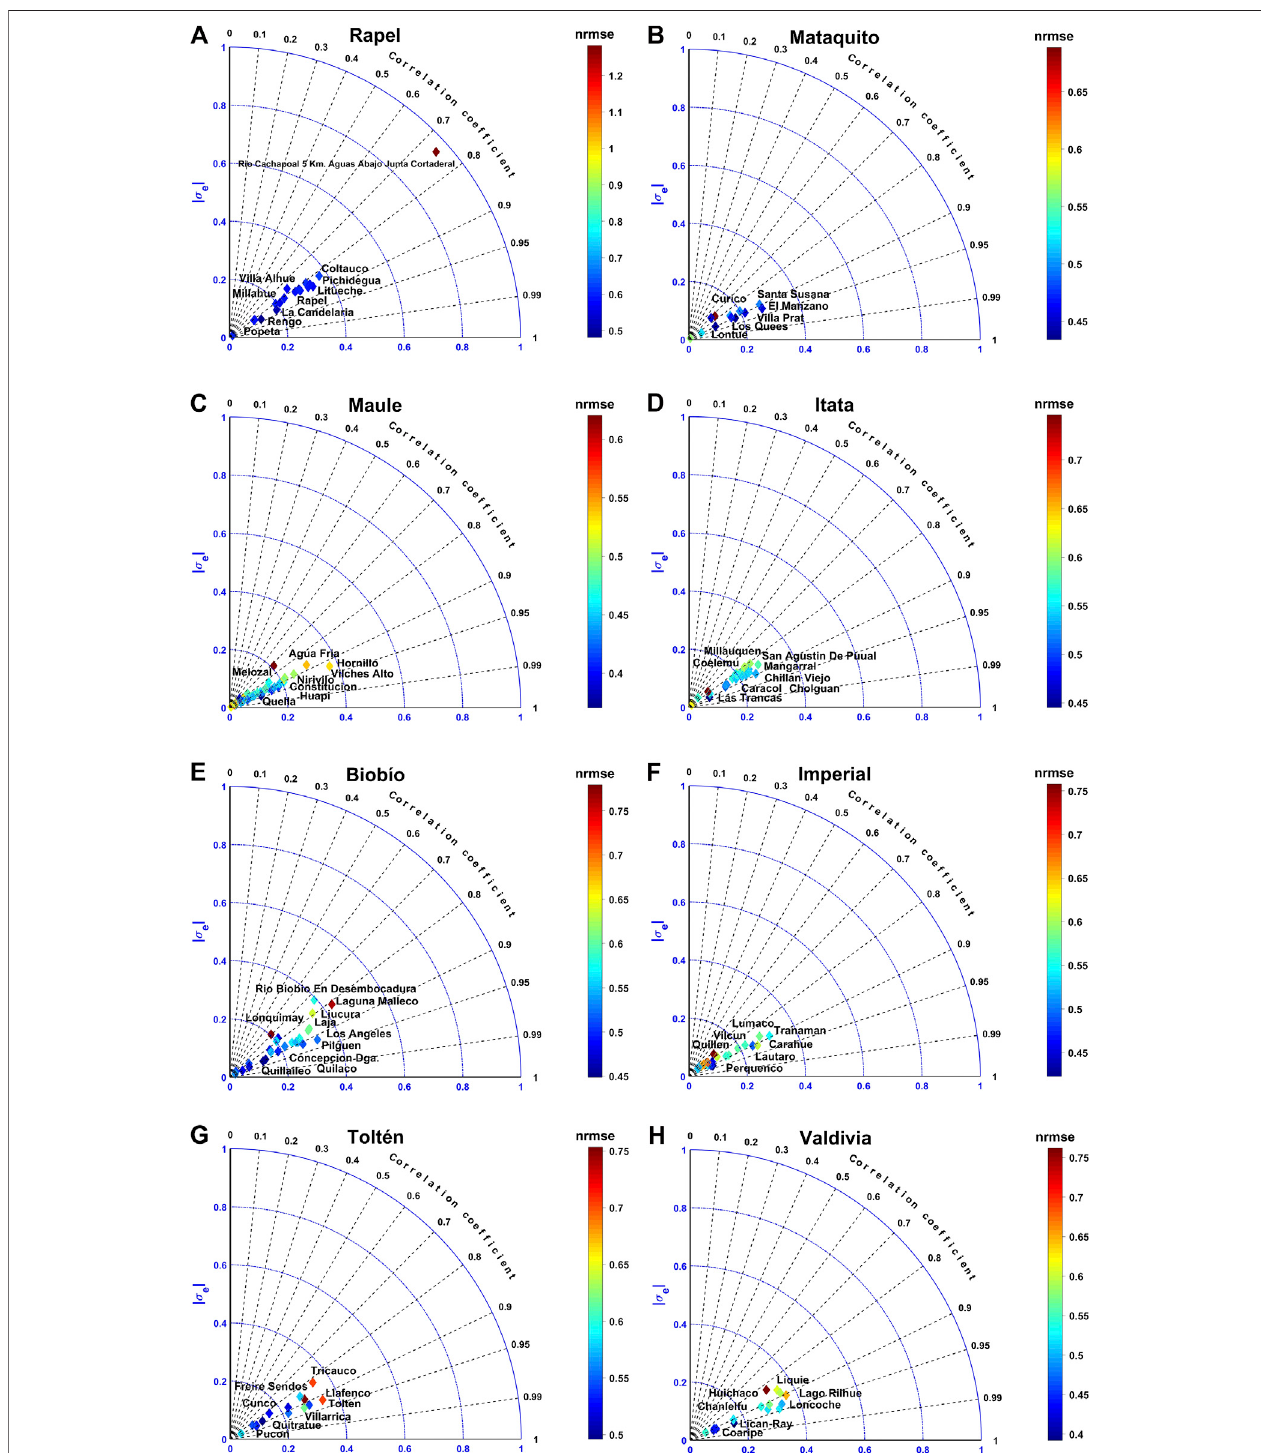
FIGURE 6 | Taylor ’ s diagrams corresponding to weather research and forecasting model performance ( Table 1 ) once fi tted ( Eq. 1 ) in basins: (A) Rapel, (B) Mataquito, (C) Maule, (D) Itata, (E) Biobío, (F) Imperial, (G) Toltén, and (H) Valdivia.